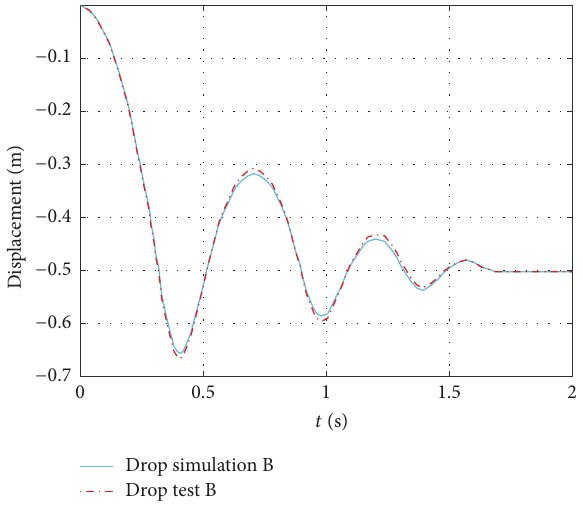
Figure 13: Comparison of results for drop analysis B.